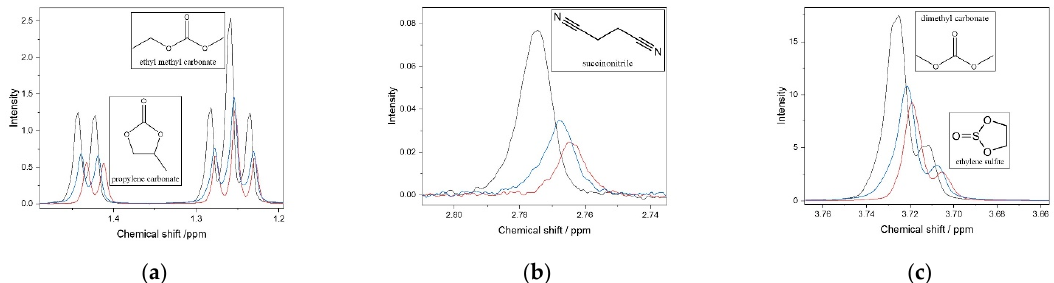
( g ) Figure 10. NMR spectra for as-received, cell failure test cell and high rate cycled cell. ( a ) solvent peaks of ethyl methyl carbonate and propylene carbonate ( b ) solvent peaks of succinonitrile ( c ) solvent peaks of dimethyl carbonate and ethylene sulfite ( d ) solvent peaks of propylene carbonate ( e ) solvent peaks of ethylene carbonate ( f ) solvent peaks of ethyl methyl carbonate and ( g ) the relative integral peaks of as-received, cell failure test cell and high rate cycled cell. The capacity loss in the cells of high currents has been ascribed to electrolyte loss at the observed localised mechanical deformation in the coating joints [12,21,22]. This would be exacerbated by the finding that the electrolyte has been consumed in testing. 3. Materials and Methods This study utilised commercial A123 18,650 cylindrical cells of nominal capacity 1.1 Ah. These are of LFP/Gr chemistry with operating voltage range 2.0–3.6 V and continuous current limits 16 A (discharge) and 5 A (charge). Details on the cells and their respective aging conditions are outlined in Table 3. Table 3. Overview of cell aging situations.